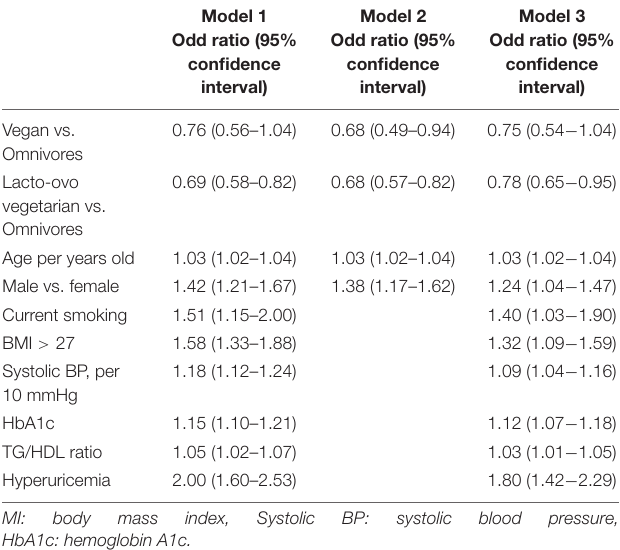
TABLE 2 | Risk in different demographic characteristics and eating habits for occurrence of CKD ( n = 2,797).